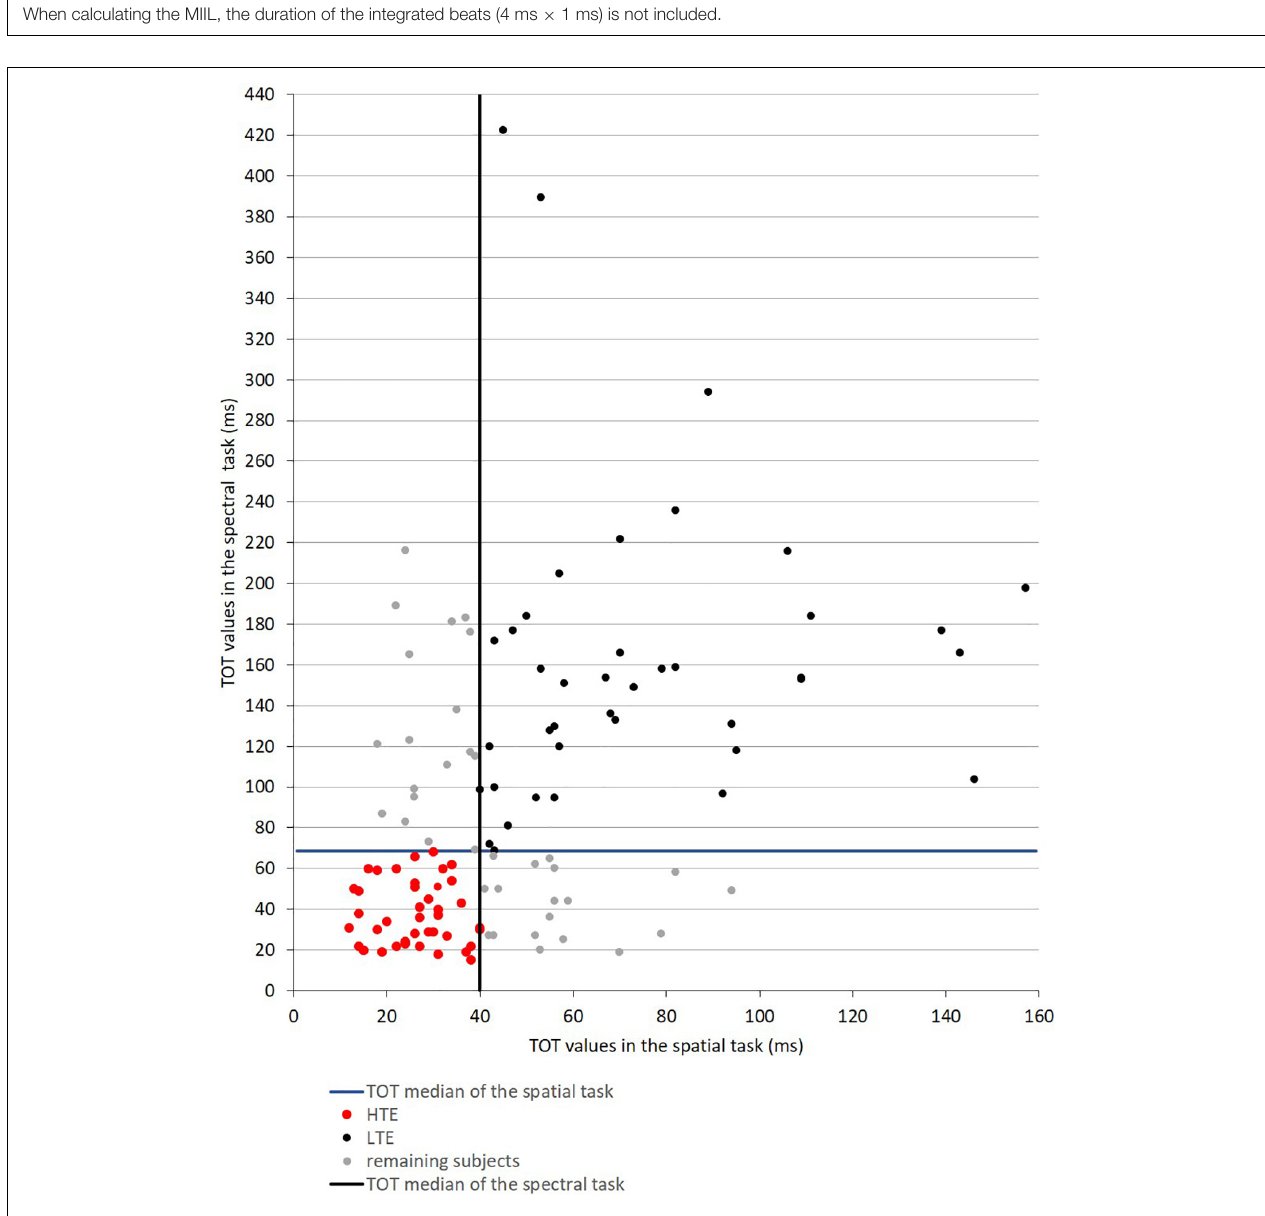
FIGURE 3 | Scatter plot data presenting TOT values obtained in the spatial and spectral temporal-order judgment tasks in the initial participant sample ( N = 118). The vertical and horizontal solid lines reflect the median values of TOT in these two tasks, indicating four quartiles of obtained results depicted with different colors.